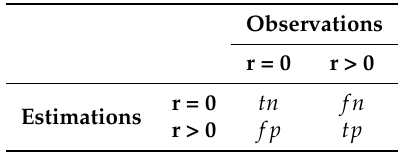
Table 5. Contingency table between the observations and the estimations, recording the number of true negatives tn , the number of false negatives fn , the number of false positives f p and the number of true positives tp .